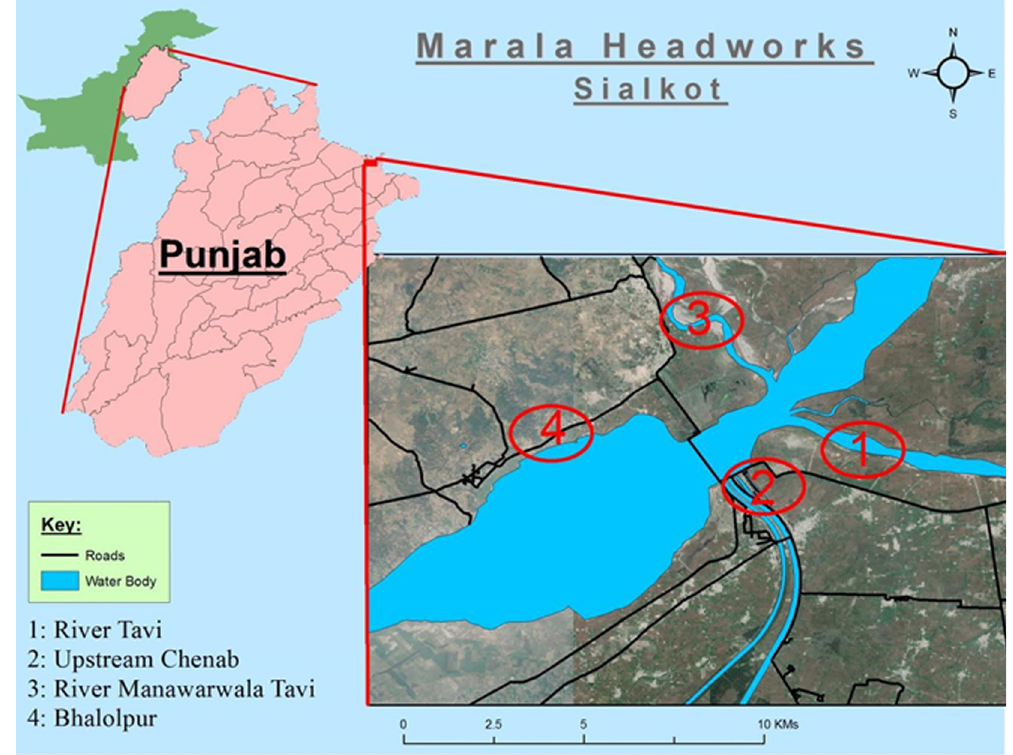
Fig 1. Map of Head Maralla showing four respective sites of the study